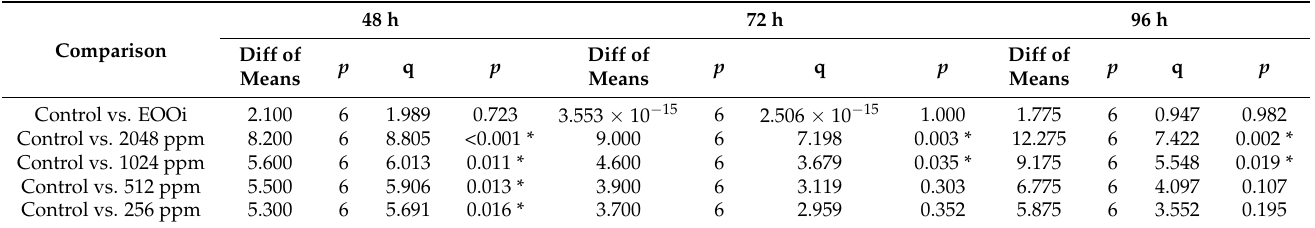
Table 10. One-way ANOVA between A. westerdjikiae colonies with the EO and the NE in all incubation periods.